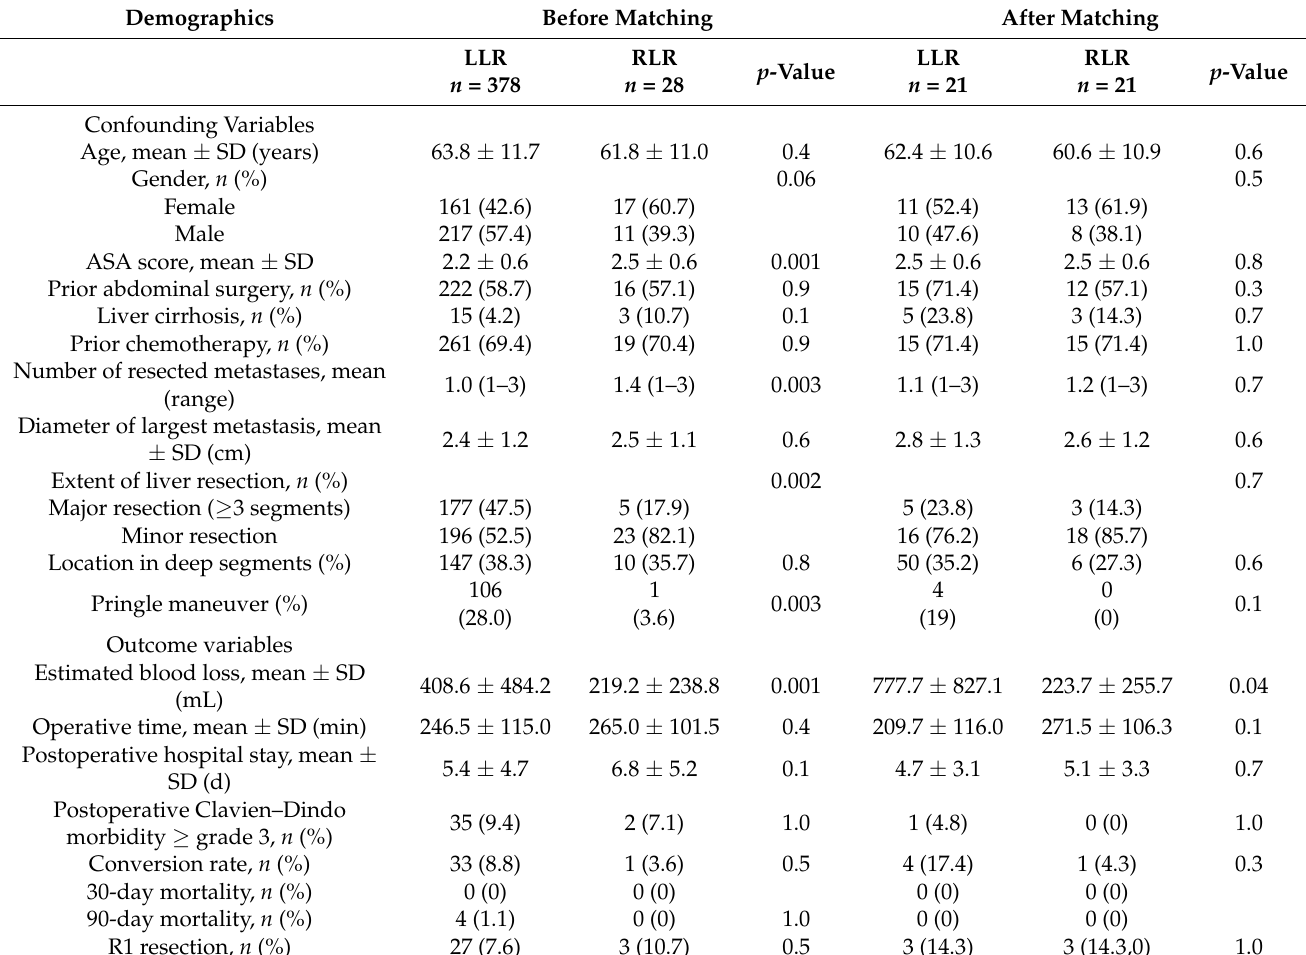
Table 4. Demographics/confounding variables and clinical outcome variables of patients receiving laparoscopic (LLR) or robotic liver resection (RLR) for colorectal liver metastasis before and after propensity score